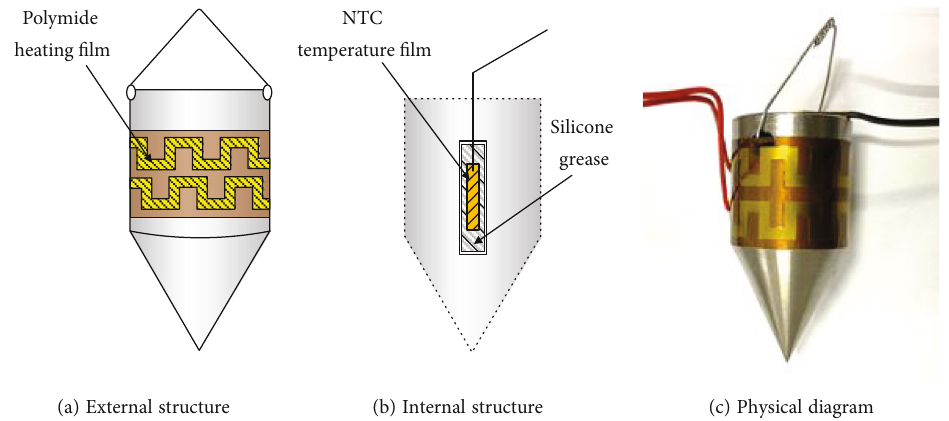
Figure 3: Schematic diagrams and a photo of the test cone.